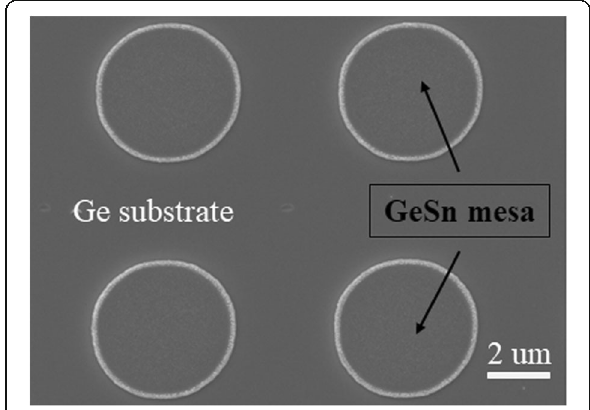
Fig. 2 Top-view SEM image of isolated 5 μ m diameter GeSn circular mesas after removal of the shadow